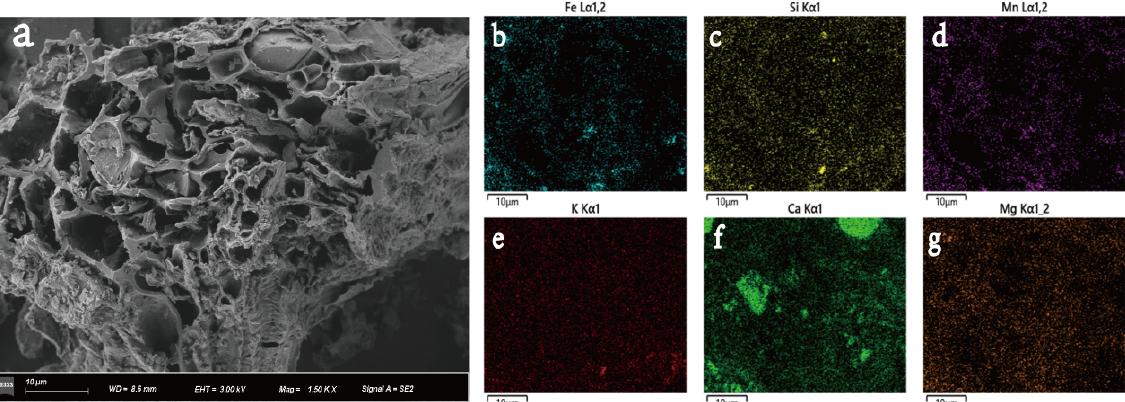
Figure 1. SEM image ( a ) and the elements Fe ( b ), Si ( c ), Mn ( d ), K ( e ), Ca ( f ), Mg ( g ) scanning mapping of T-BC.